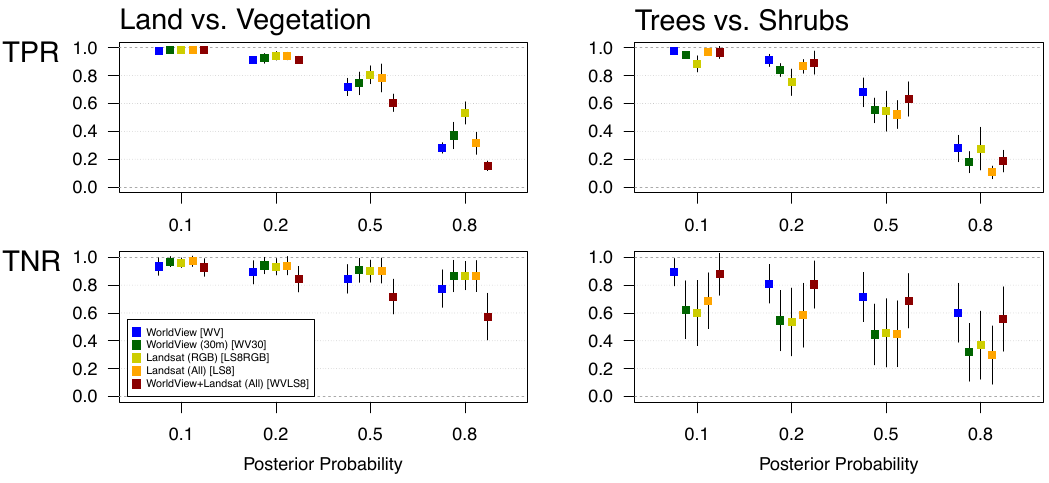
Figure 4. True Positive Rate (TPR) and True Negative Rate (TNR) across regions for (2-class) probability mode classification, with 95% CI calculated across tiles, grouped by classifier and posterior probability